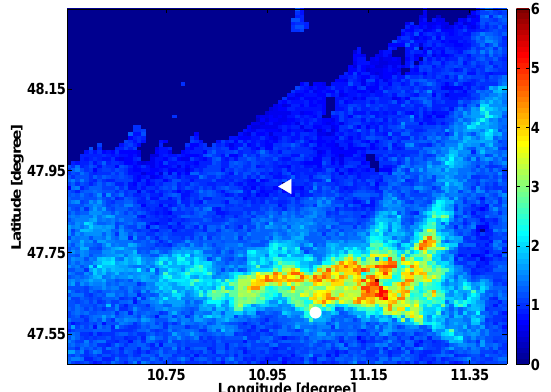
Fig. 9. Precipitation field [mmh − 1 ] in the data space derived with the Maximum Theta method for 14 July 2008 (13:00). The position of Hohenpeissenberg (Garmisch-Partenkirchen) is indicated by a white triangle (circle).